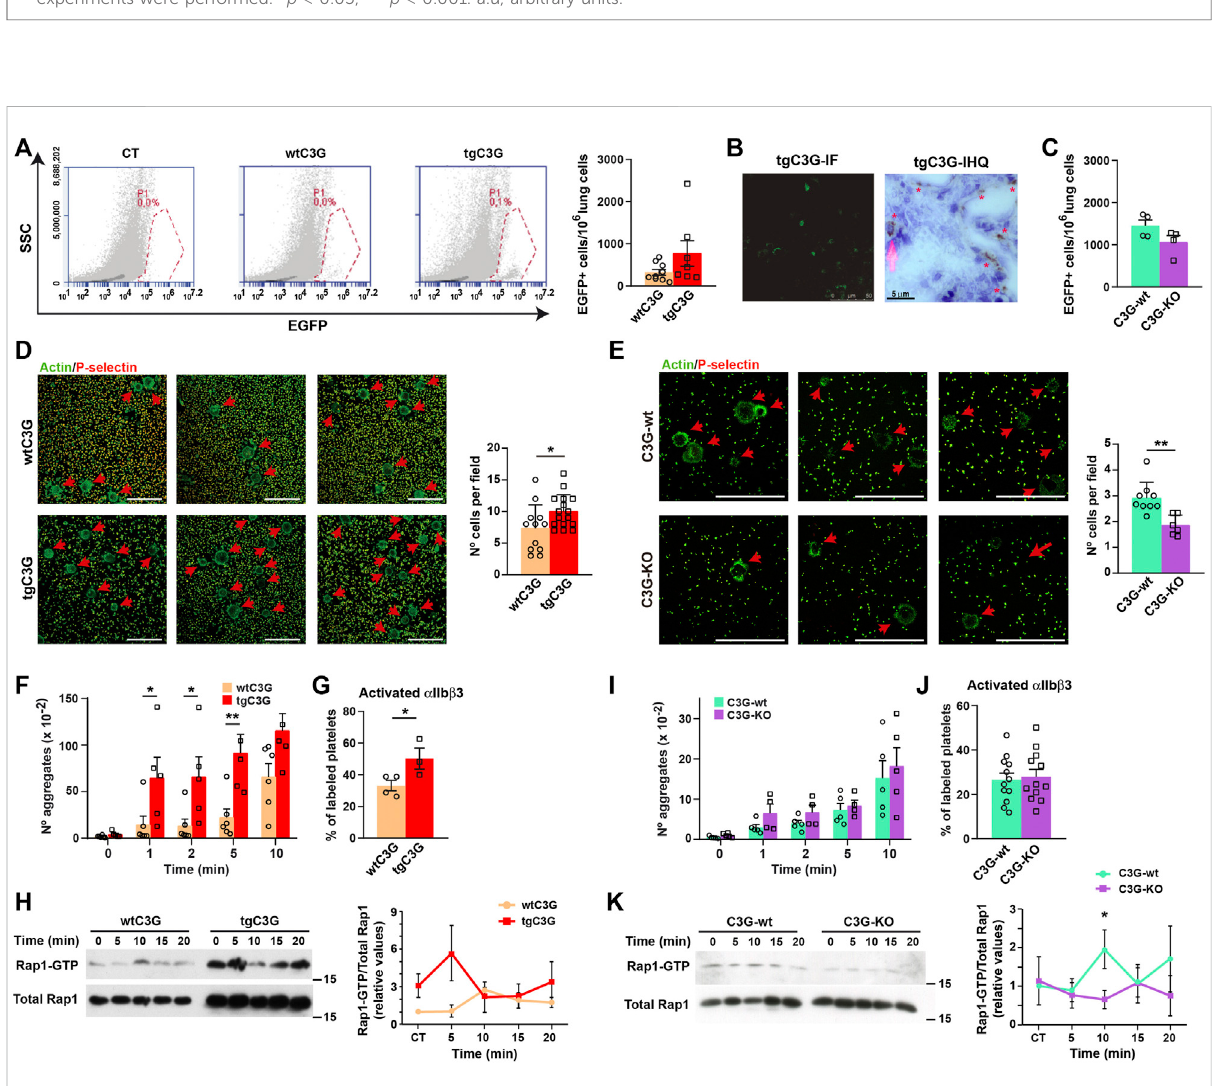
FIGURE 3 Platelet C3G favors an early onset of melanoma metastasis through regulation of melanoma cell adhesion and TCIPA. (A) Representative fl ow cytometry plots of lung homogenates from wtC3G and tgC3G animals injected with EGFP-expressing B16-F10 melanoma cells. CT: lung homogenates from untreated mice. Histogram represents the mean ± SEM of the number of EGFP + cells in 1,000,000 lung cells. (B) Representative sections of lung tissue from tgC3G mice analyzed by immuno fl uorescence (IF, left) or immunohistochemistry (IHC) with anti-GFP antibodies (right). Presence of B16-F10 cells is indicated with asterisks. Bar: 5 μ m. (C) Mean ± SEM of the number of EGFP + cells in 1,000,000 lung cells from C3G-KO and C3G-wt mice. (D,E) Representative immuno fl uorescence images of B16-F10 cells adhered to poly-L-Lysine-coated plates, after co- culturingwithtgC3GorwtC3Gplatelets (D) orC3G-KOandC3G-wtplatelets (E) ,stainedwithanti-P-selectin+anti-goatCy3antibodies(tovisualize platelets) and phalloidin-488 to detect actin. Arrows indicate the presence of B16-F10 cells. Bar: 50 μ m. Histograms represent themean ± SD of the number of B16-F10 cells per fi eld. (F,I) Mean ± SEM of the number of platelet aggregates from the indicated genotypes upon stimulation with B16- F10 cells for the indicated time periods. (G,J) Mean ± SEM of the percentage of platelets with activated integrin α IIb β 3. (H,K) Platelets from the indicated genotypes were stimulated with 1 × 10 3 B16-F10 cells and Rap1-GTP levels determined by pull-down assay. Left: representative western blots. Right: line/scatter plots of Rap1 levels (n=3). Values (mean ± SEM) are relative to those in non-stimulated wild-type platelets and were normalized to total Rap1 levels. * p < 0.05, ** p <